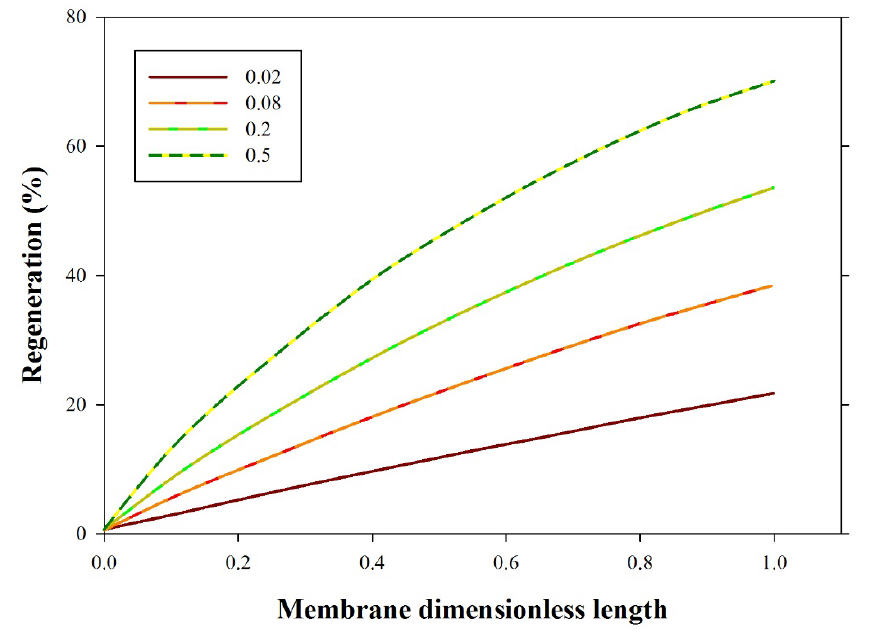
Figure 4. Effect of solvent initial feed rate (50, 80, 110, 140, and 70 mL/min) at constant gas feed rate (10 mL/min) on the CO 2 removal efficiency with time.